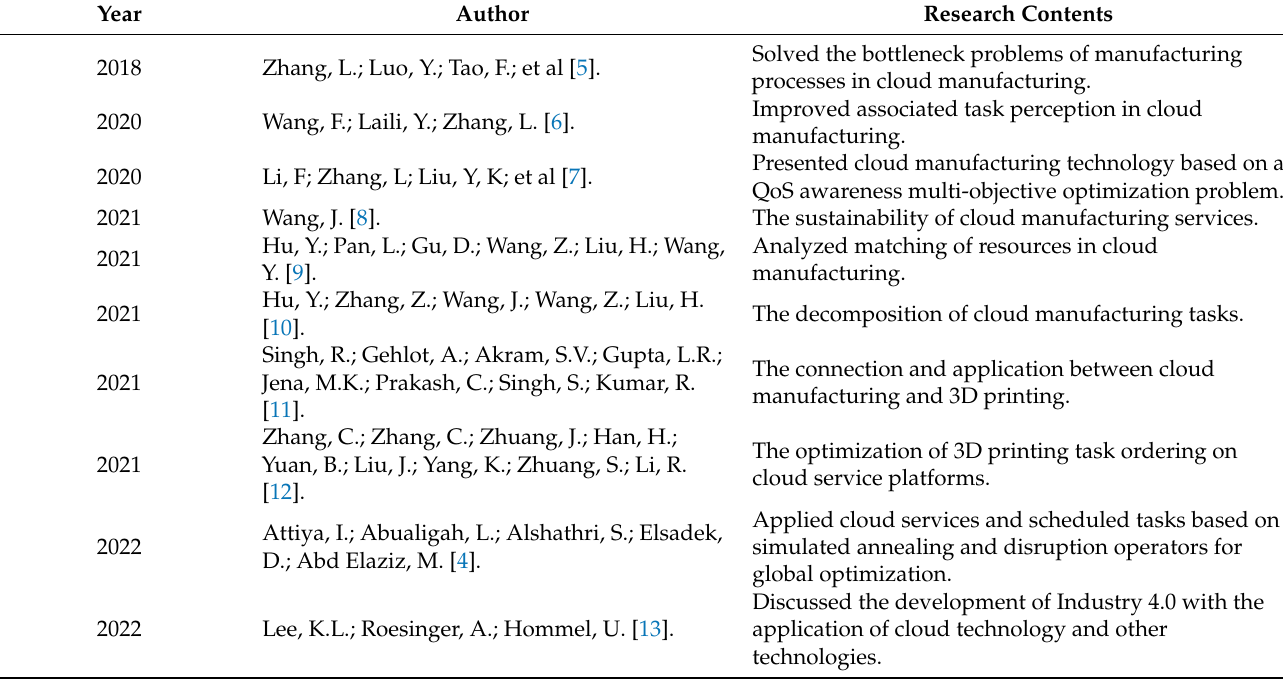
Table 1. Researchers and studies related to cloud